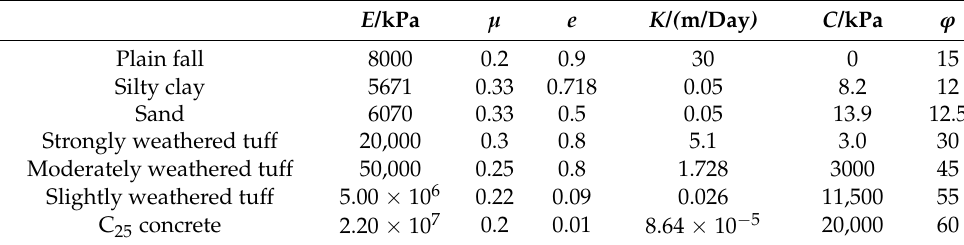
Table 3. The empirical parameters of concrete.